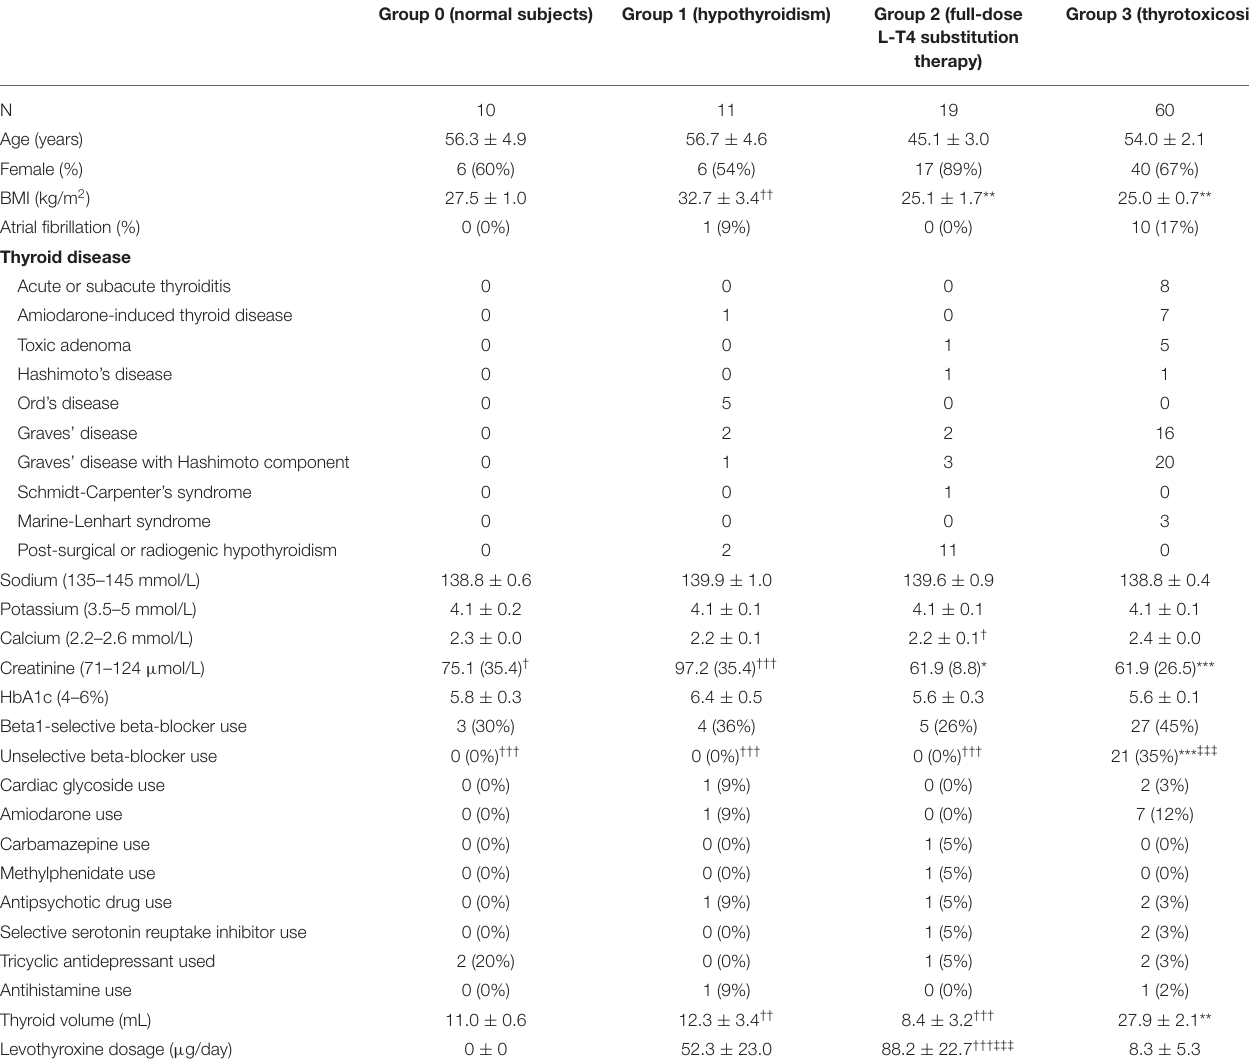
TABLE 1 | Basic characteristics of study population.